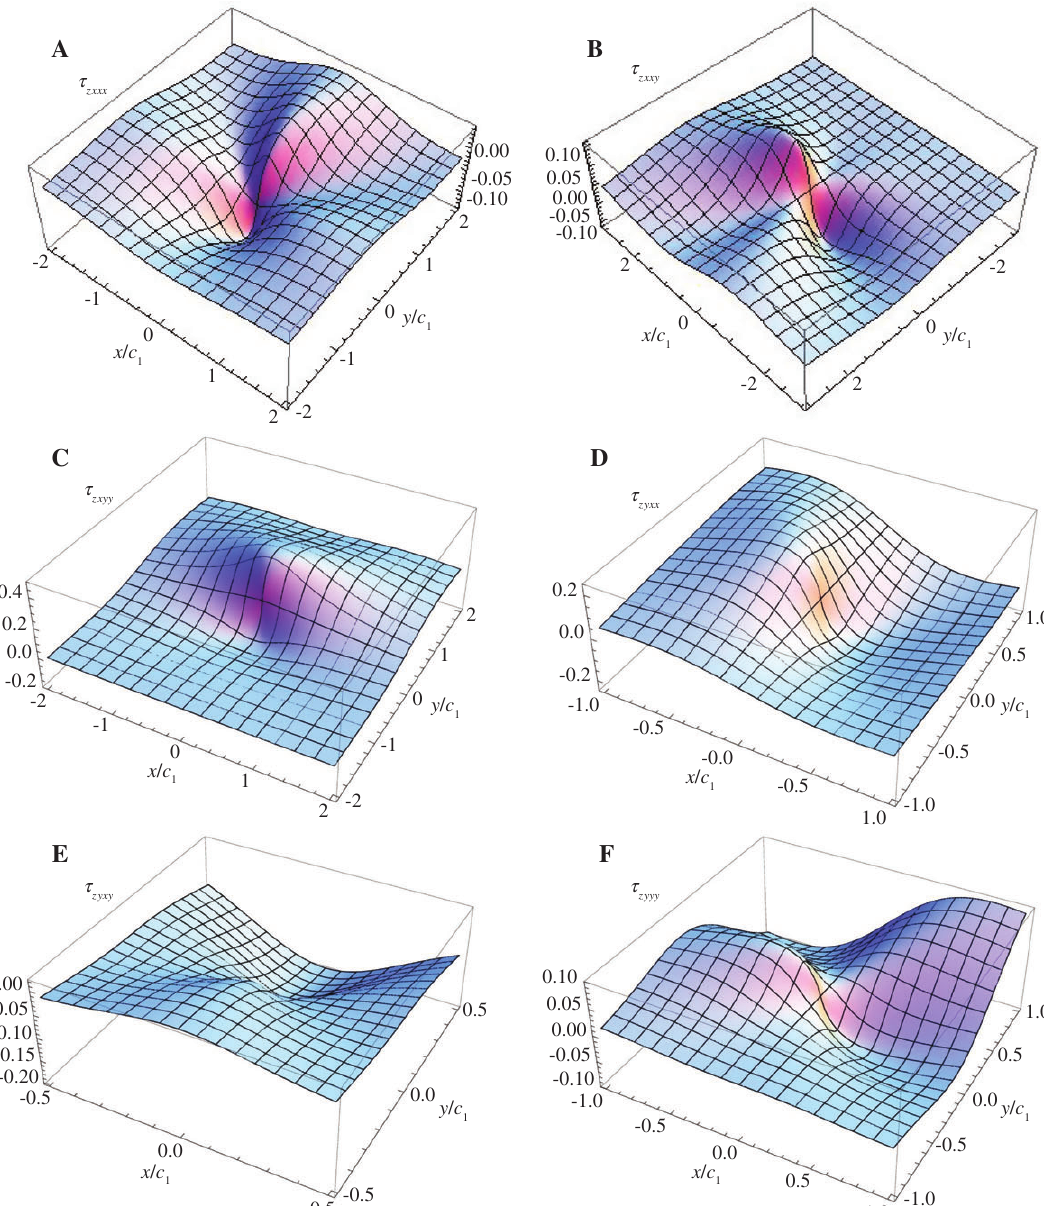
= 0.5. Double / c 2 1